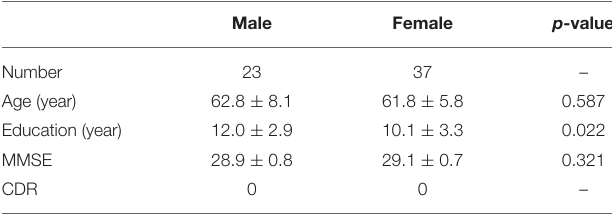
TABLE 1 | Demographic and cognitive characteristics of all